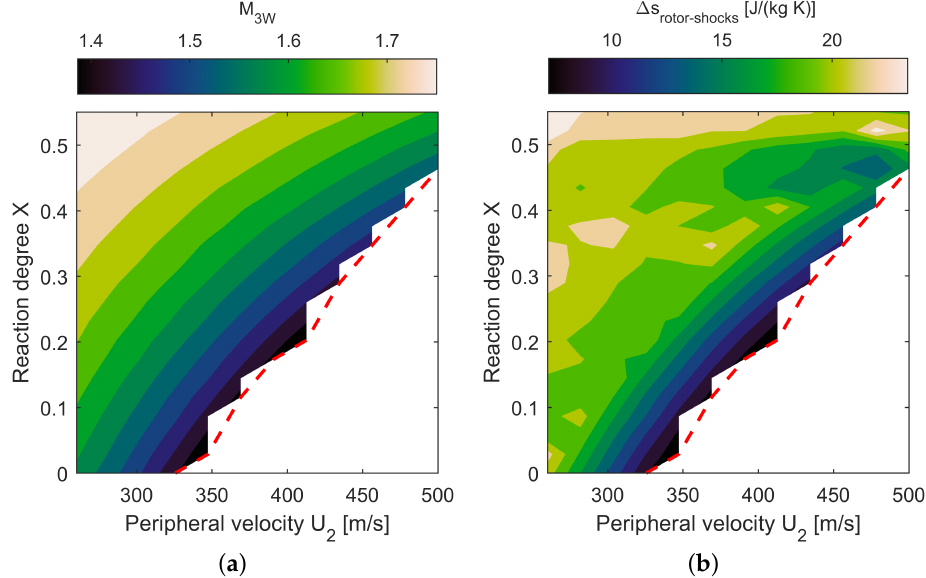
Figure 16. Relative Mach number at rotor inlet ( a ) and entropy production [J/(kg K)] due to shocks in the rotor ( b ) for constant stator blade height and different reaction degree and peripheral